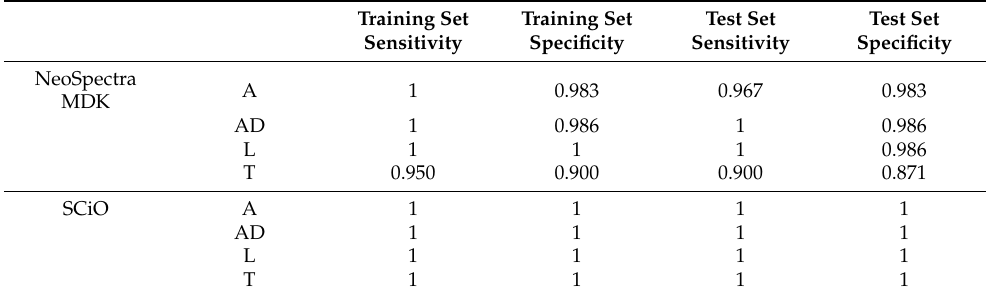
Table 1. Classification of different classes of insect powders applying PLS2-DA classification to NeoSpectra MDK and SCiO data. The values corresponding to the training set are obtained using